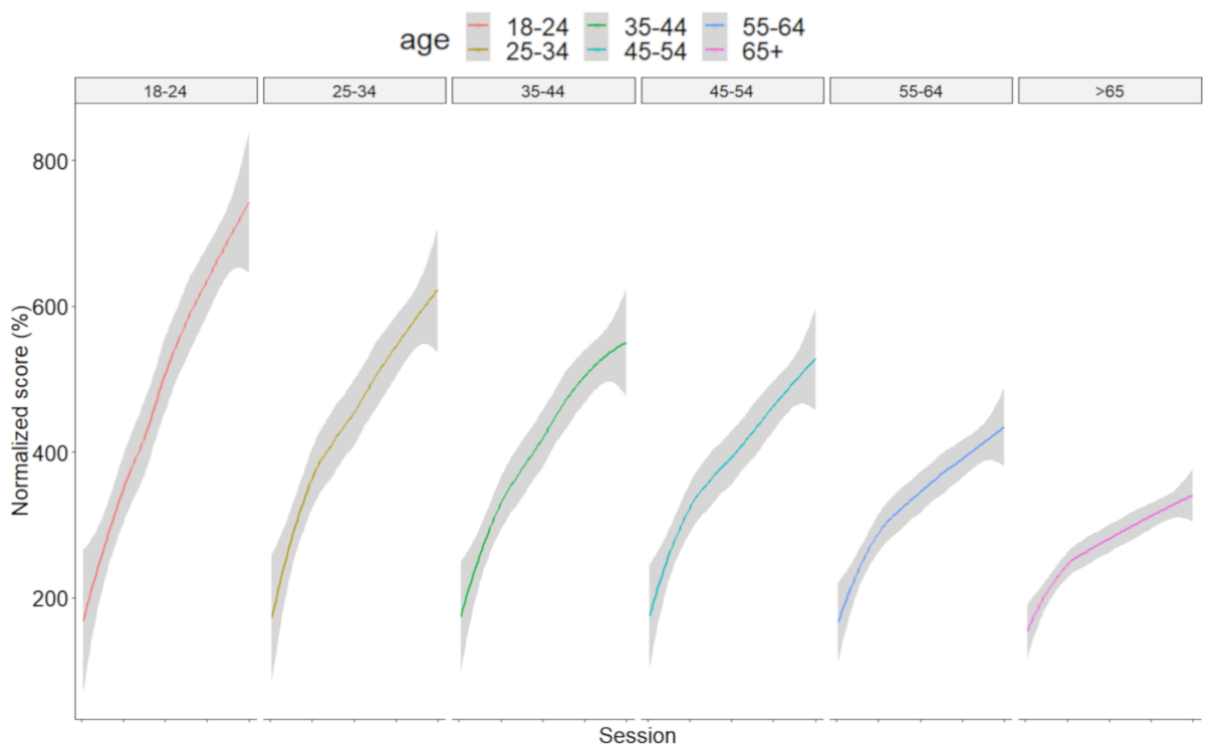
Figure 3. Mean normalized results of the 7 cognitive mobile games for the different age groups. Normalized results i = 100 + [( Results i - Results 1 / Results 1 ) × 100]. Grey bands indicate 95% confidence